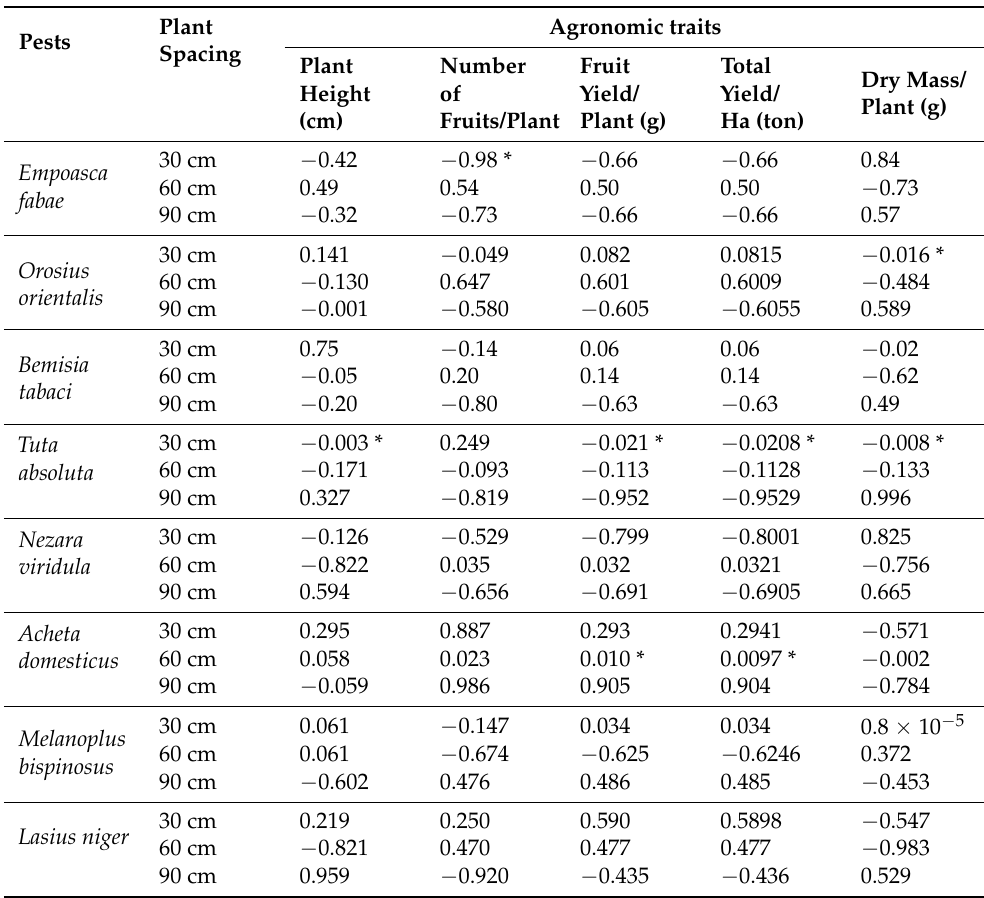
Table 4. Correlation (r) between the insect pest population and the agronomic traits of the tomato variety ‘Areenez F1’; the plants were grown at three different plant spacings (30 × 50 cm, 60 × 50 cm and 90 × 50 cm) during the winter season of 2020–2021. Plant Agronomic traits Pests Spacing Total Fruit Number Plant Yield/ Yield/ of Height Plant Plant (g) Fruits/Plant (cm)